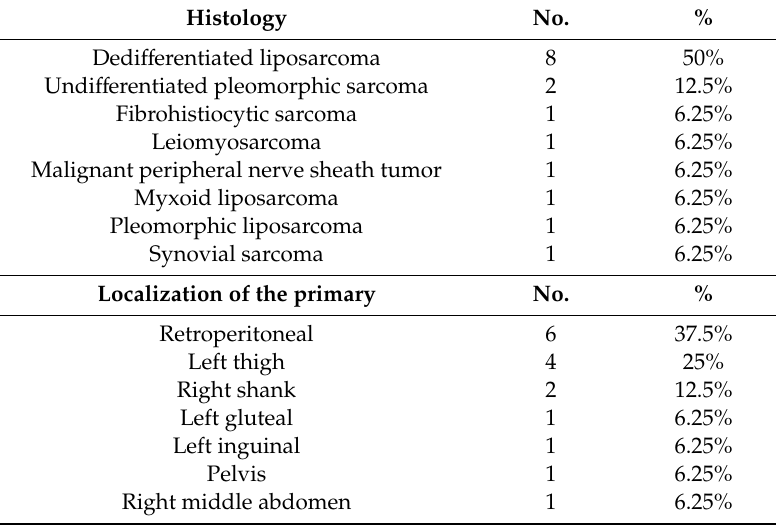
Table 1. Histopathological characteristics and localization of the soft tissue sarcoma (STS) of the 16 studied patients. Histology No. % Dedi ff erentiated liposarcoma 8 50% Undi ff erentiated pleomorphic sarcoma 2